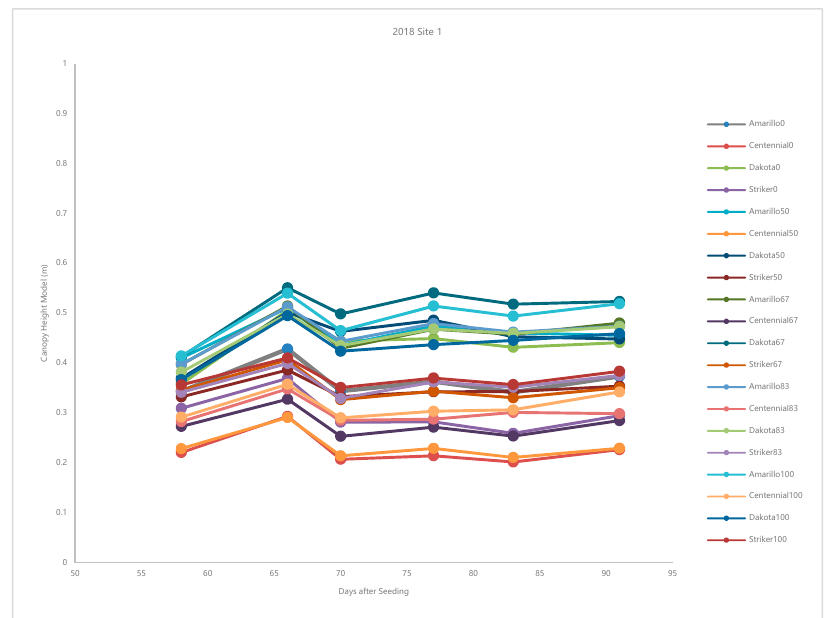
Figure A1. The mean of image-derived heights of treatments in each flight from pre-lodging to post- lodging in 2018 and 2019 sites. The legend labels the treatments of variety and semi-leafless ratio.